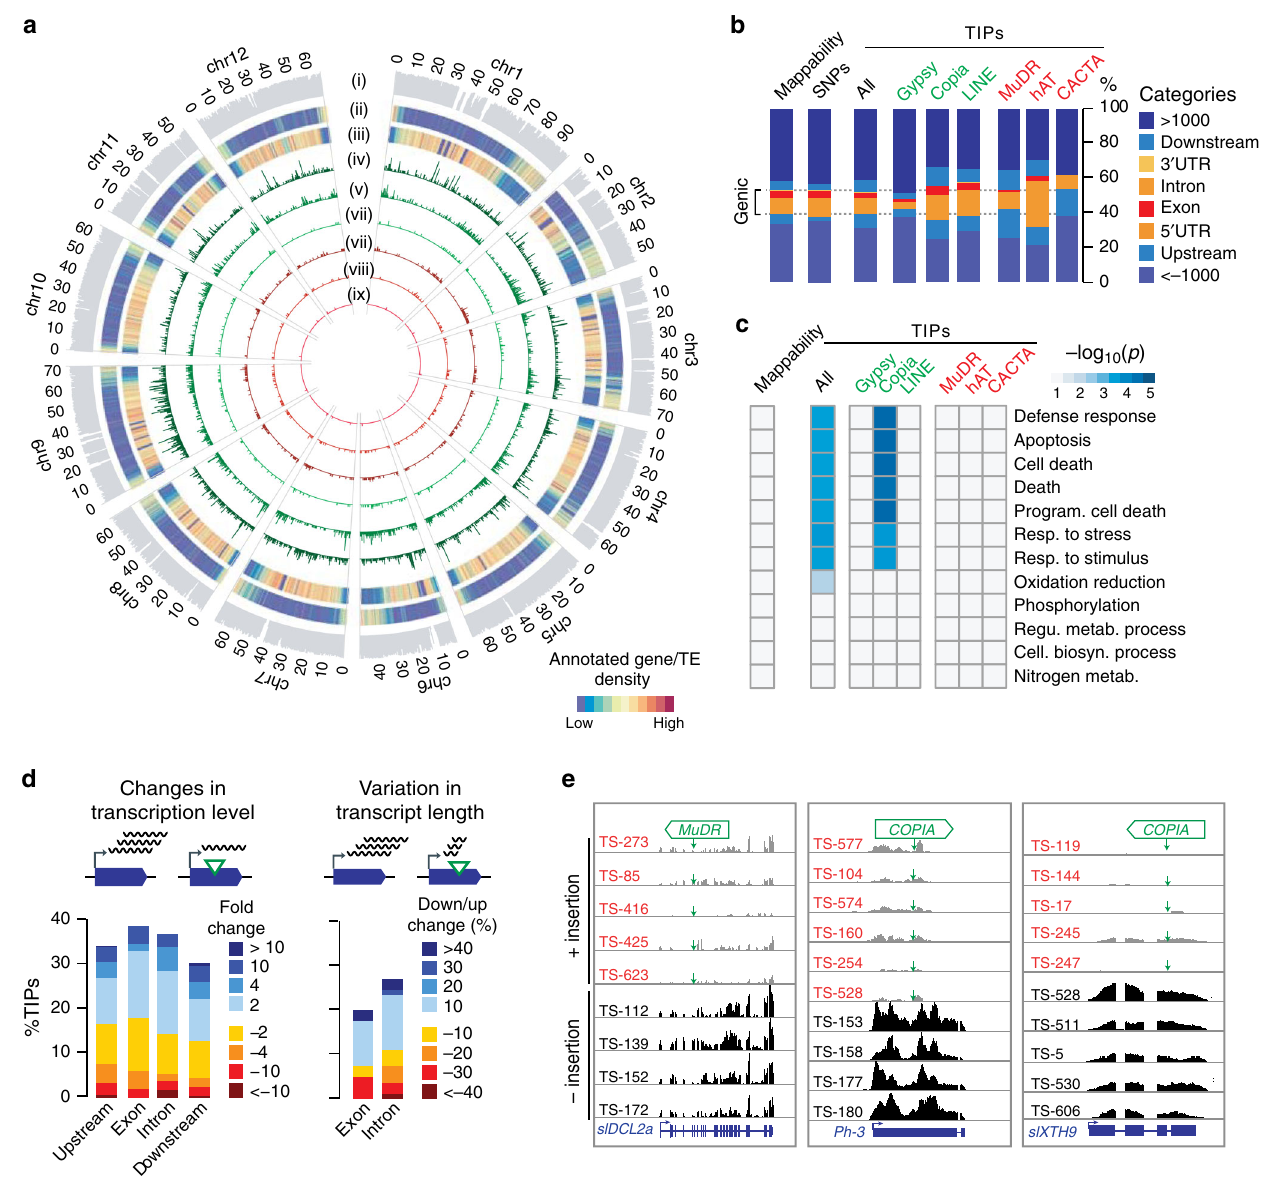
Fig. 2 Landscape and transcriptional impact of TIPs. a Chromosomal short-read mappability (i) and distributions of reference genes (ii) and TEs (iii) as well as TIPs by superfamily (iv – ix) across the 12 chromosomes of tomato genome. (iv) GYPSY , (v) COPIA , (vi) LINE , (vii) MuDR , (viii) hAT , and (ix) CACTA . b Distribution of TIPs over genic features. UTR, untranslated transcribed region. c GO-term analysis of genes with TIPs. d Proportion of TIP-containing genes with changes in transcription level or variation in transcript length in relation to the presence/absence of the TE insertion. e Genome browser view of RNA-seq coverage for three TIP-containing genes in accessions carrying or not the TE insertions. Green arrows indicate the position of TE insertion sites. Source data of Fig. 2c, d are provided as a Source Data fi